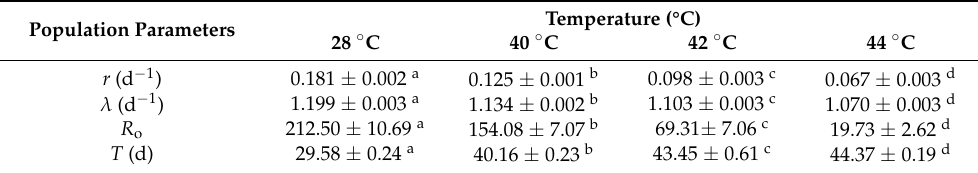
Figure 5. Age-specific reproductive values ( v xj ) of Ophraella communa reared under different tempera- tures. ( A ): 28 ◦ C, ( B ): 40 ◦ C, ( C ): 42 ◦ C, ( D ): 44 ◦ C. Table 4. Effects of periodical high-temperature exposure on calculated population parameters for the ragweed beetle Ophraella communa